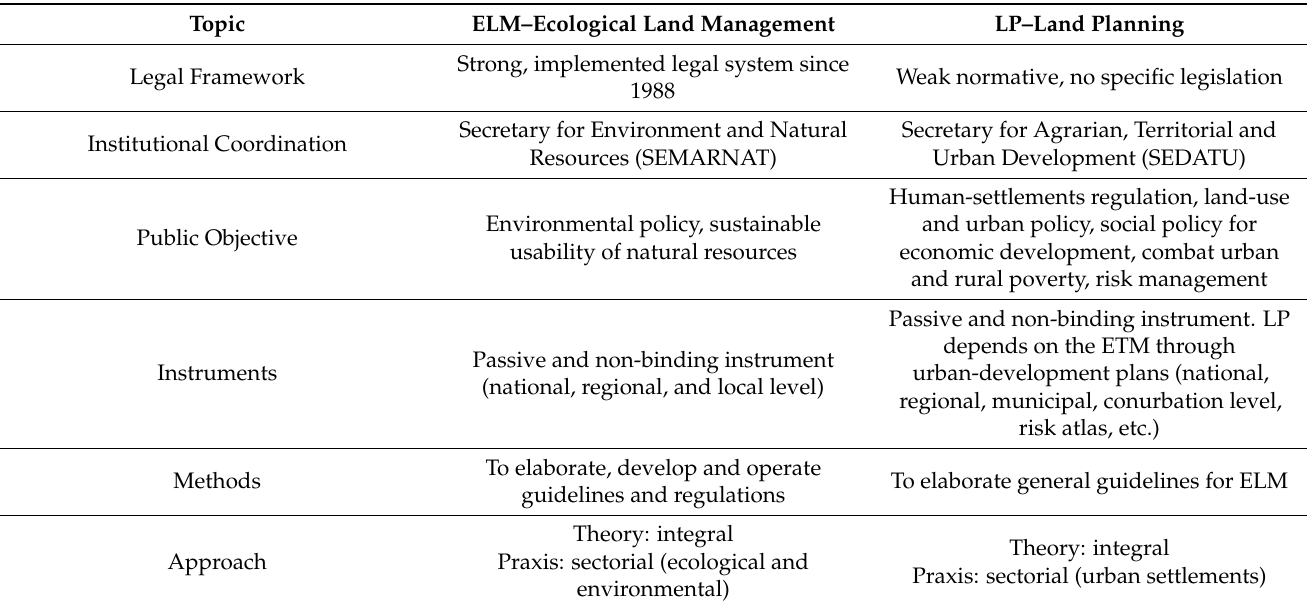
Table 3. Land-management features in Mexico. Source: adapted from Salazar Izquierdo and Verdinelli [43]. ELM–Ecological Land Management LP–Land